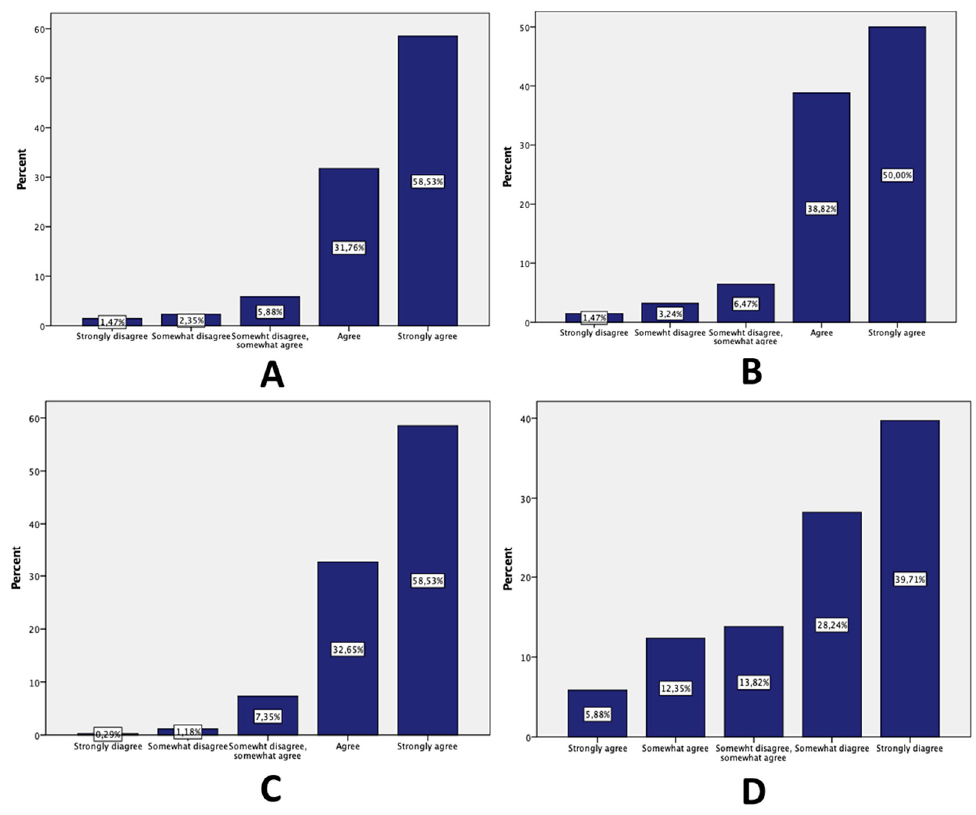
Figure 1. Participants’ responses assessing levels of trust in medical researchers. ( A ) Physicians involved in research care only about the best for each patient. ( B ) Physicians tell their patients all the information they need to know about the study. ( C ) I completely trust doctors involved in medical research. ( D ) Physicians involved in research treat patients like “guinea